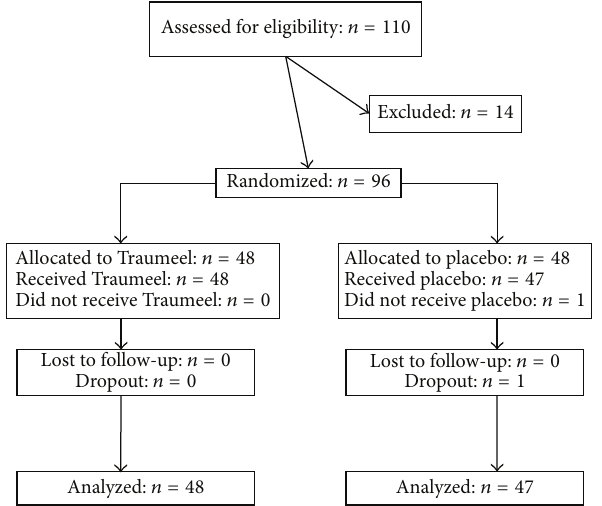
Figure 1: Study flow chart. 110 subjects were assessed for eligibility in the clinical trial and thereof 96 subjects were randomized. There was one dropout in the placebo